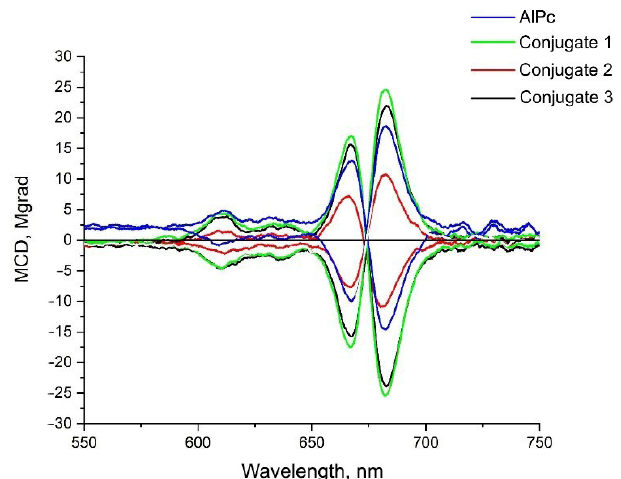
spectra themselves according to identification of bands in the MCD spectrum in work [40]. Figure 6. Spectra of magnetic circular dichroism of the studied samples. The samples were dissolved in distilled water. The molar concentration of QDs in three conjugates was 33 µ M. The molar concentration of AlPc in conjugate 1 and 3 was 20.4 µ M, in conjugate 2 was 10.2 µ M. MCD-581 magnetic attachment was at a field strength of − 1.5, 0, 1.5 T.